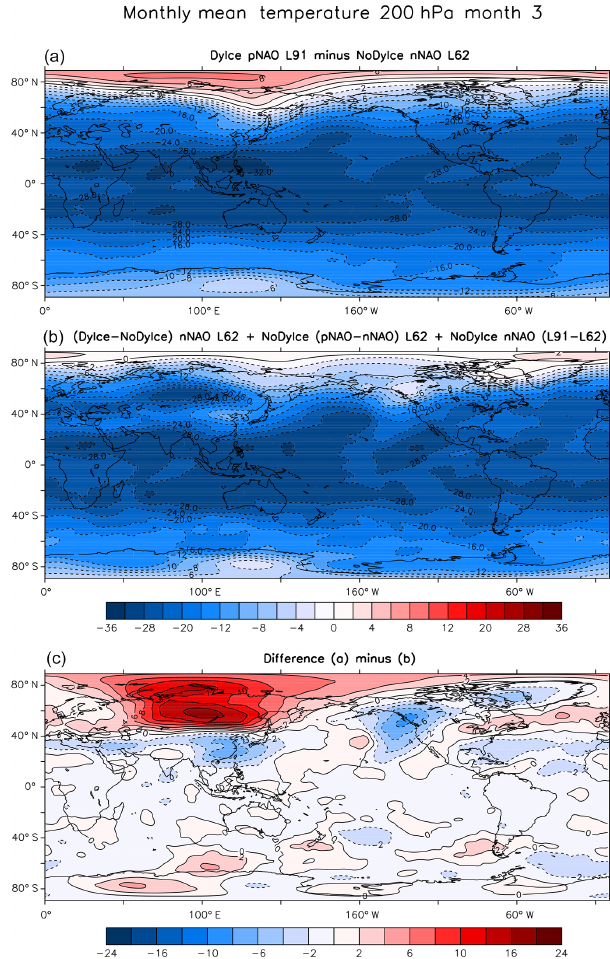
Figure 4. Monthly mean air temperature at 60 ◦ N. (a) Difference between DyIce pNAO L91 and NoDyIce nNAO L62 . (b) Sum of the differences: NoDyIce (pNAO-nNAO) L62 , (DyIce-NoDyIce) nNAO L62 , and NoDyIce nNAO (L91-L62) . (c) Difference between ( a ) and ( b